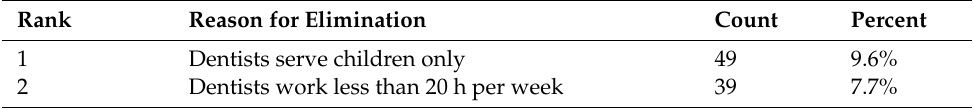
Table 3. Reasons for eliminated status.